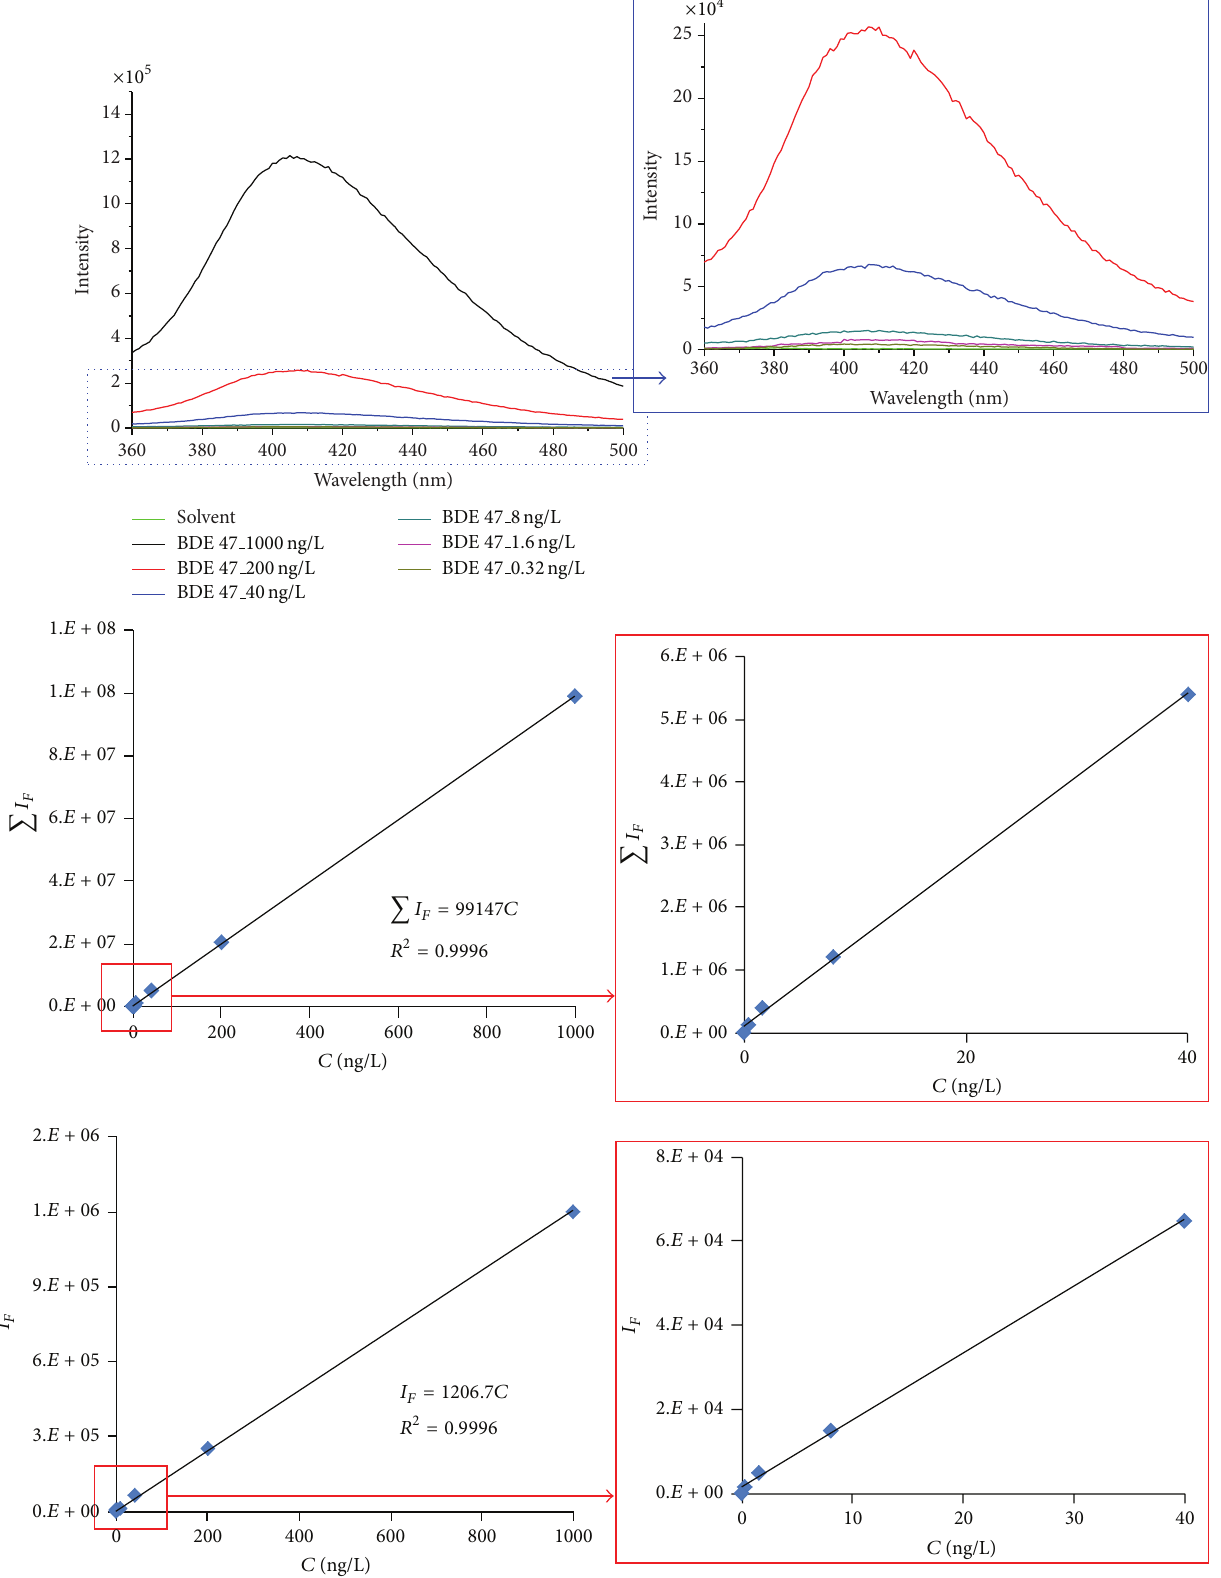
= 302 nm) as a function of BDE 47 concentration (0.32 ng/L to 1000ng/L). The figure inserts show the linear Figure 3: Emission spectra ( 𝜆 exc correlation between the peak intensity 𝐼 𝐹 (at 406 nm) or peak area ∑ 𝐼 𝐹 (from 360 to 500 nm) with BDE 47